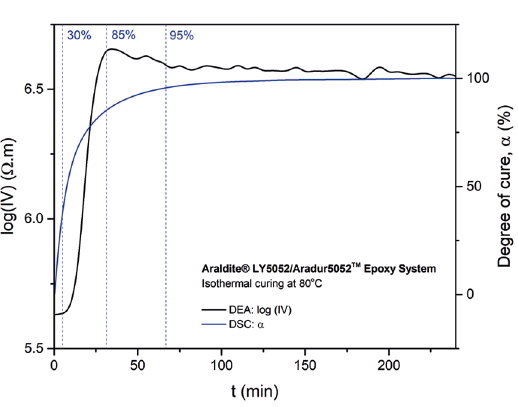
Figure 10. Logarithm of ion viscosity (log(IV)) versus degree of cure ( α ) for the Araldite ® LY5052/Aradur5052 TM epoxy system under isothermal cure at